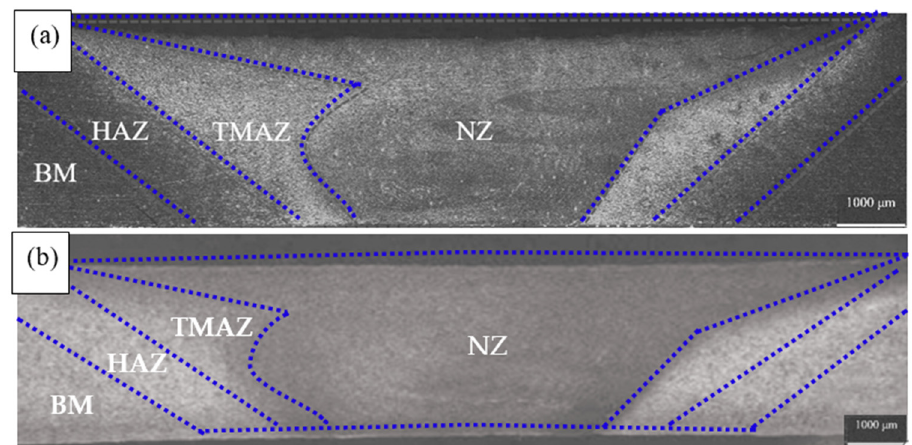
Figure 5. The optical micrograph of welding zones after deformation ( a ) 0%, ( b ) 10%.